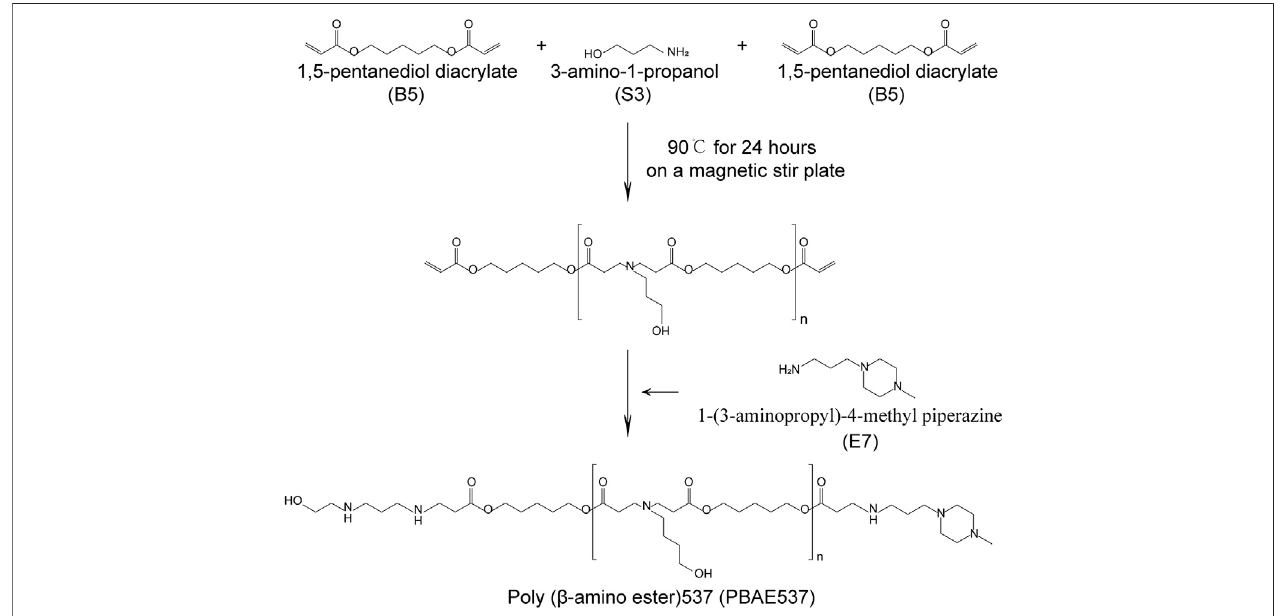
FIGURE1| SynthesisofPBAE537.SynthesisofPBAE537.ThePBAEnanomaterialPBAE537wasformedbymixing1,5-pentanedioldiacrylate(B5)with3-amino- 1-propanol (S3) and stirring at 90 ° C for 24 h on a magnetic stirring plate and adding 1-(3-aminopropyl)-4-methyl piperazine (E7).